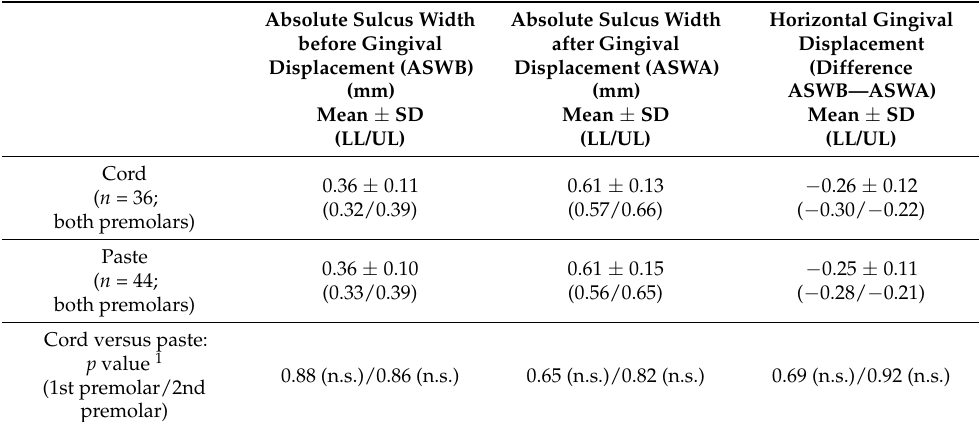
Table 4. Absolute sulcus width before (ASWB) and after (ASWA) gingival displacement and horizon- tal gingival displacement for the cord and the paste